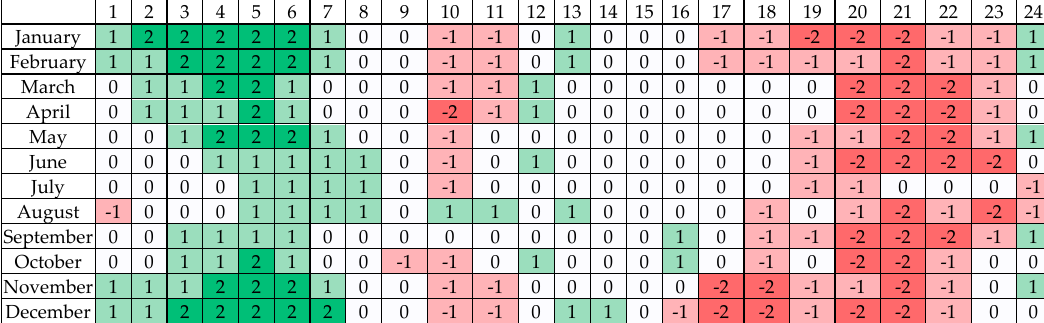
Figure 17. Strategy to optimise the load shifting: Saturdays. ( − 2, Green) Strong Load reduction; ( − 1, Light Green) Weak Load reduction; (0, White) No Load variation; (1, Light Red) Weak Load increase; (2, Red) Strong Load increase.